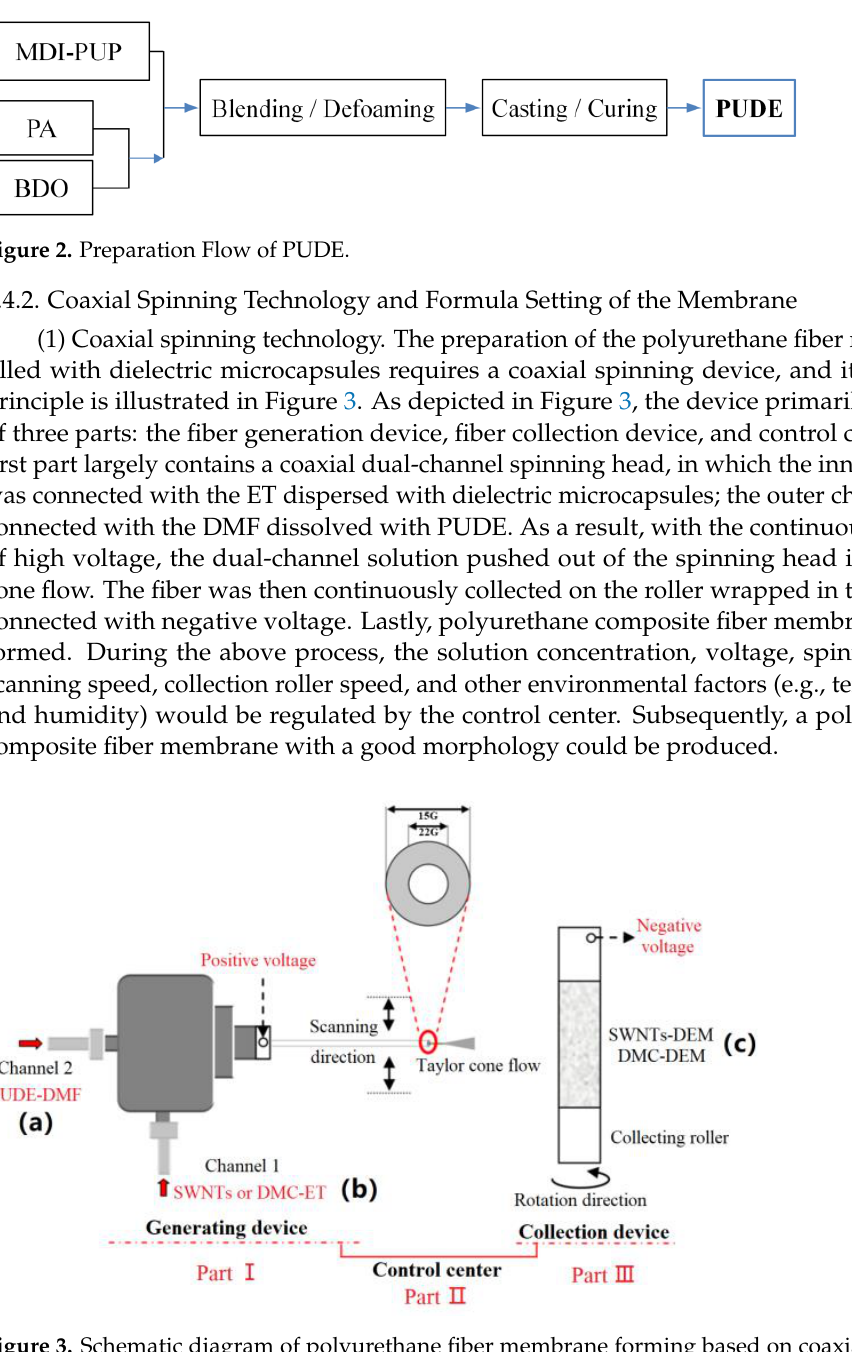
Figure 3. Schematic diagram of polyurethane fiber membrane forming based on coaxial spinning. ( a ) PUDE-DMF is a PUDE solution dissolved in N, N-dimethylformamide; ( b ) SWNTs or DMC-ET are SWNTs or the dielectric microcapsules dispersed in ether; ( c ) SWNTs-DEM or DMC-DEM are the polyurethane composite fiber membranes filled with SWNTs or dielectric microcapsules, respectively. (2) Formulation